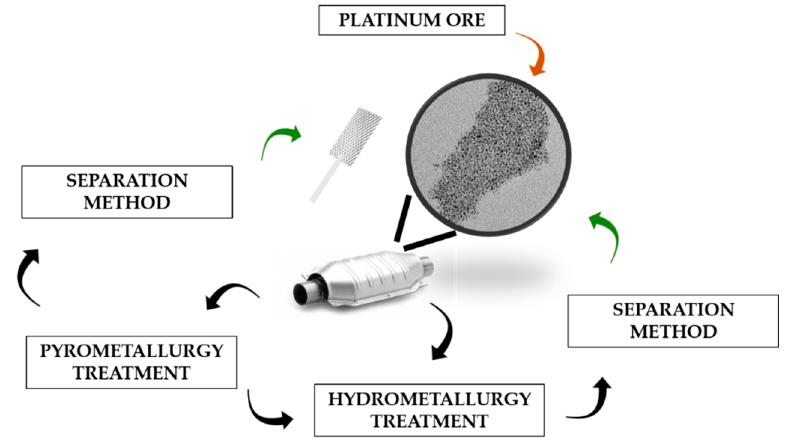
Figure 2. Different routes of recycling Pt through conventional pyro/hydrometallurgical methods.